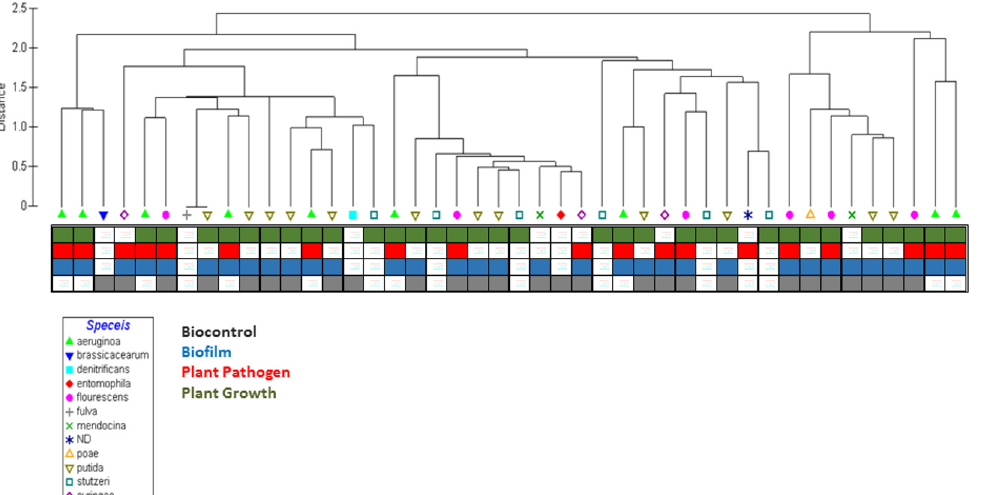
Fig 2. Clustering Pseudomonad genomes using enzyme function counts. The “ Primer 6 ” core package and enzyme function profile data were used to generate hierarchical clusters. No obvious pattern by species or by ecological function is apparent using only enzyme function count and hierarchical clustering. Suggesting additional data and/or alternate methods are required to deduce Pseudomonad environmental niche using sequenced and annotated